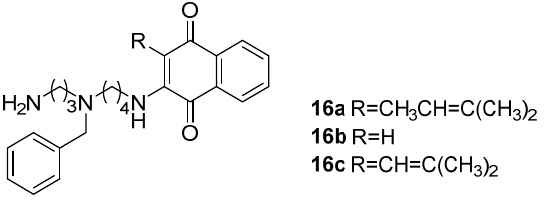
Figure 14. Chemical structures of the naphthoquinone ‐ polyamine conjugates, 16a – 16c [81].